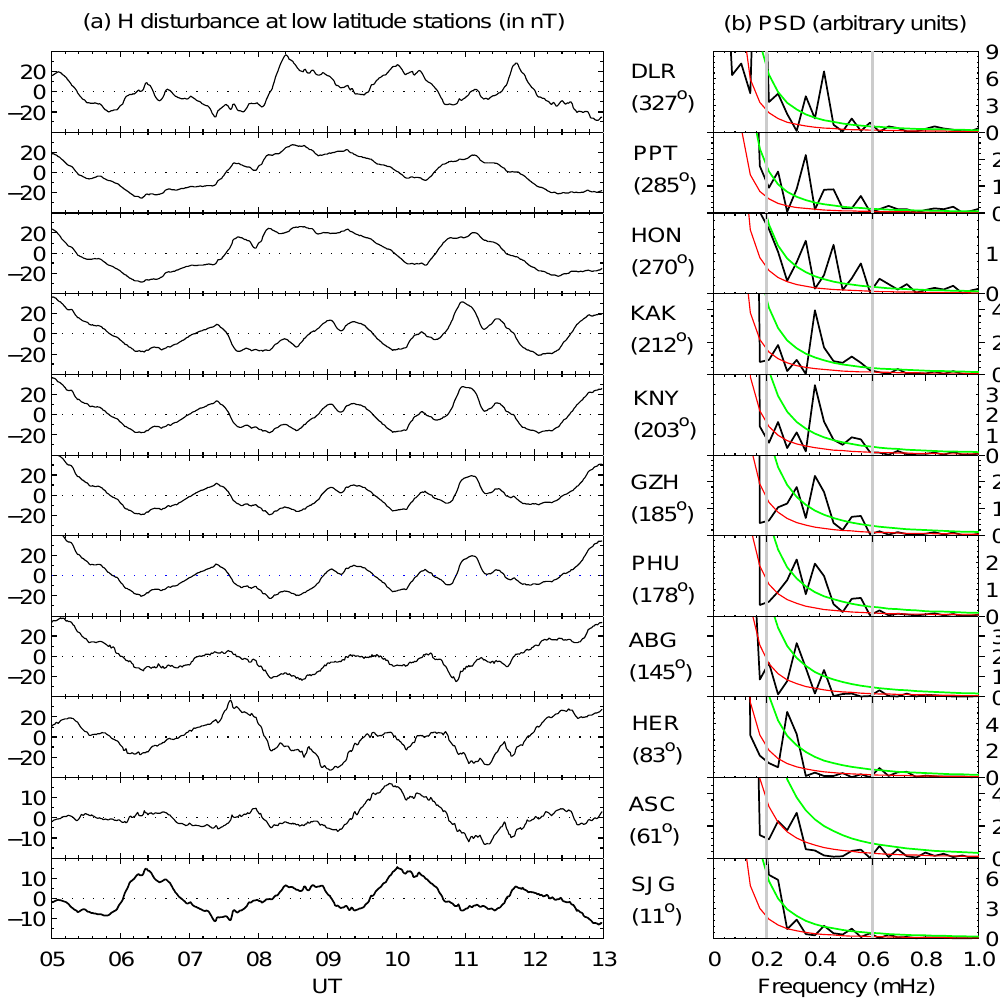
Fig. 2. 1H disturbance and FFT power spectra during 05:00–13:00UT on 15 October 2003. (a) 1H disturbance after removing the linear trend at longitudinally distributed 11 low latitude stations. Codes of stations and magnetic longitudes are given on the right side of the subplots. (b) Normalized power spectral density of 1H , mean red noise power (red curve) and 95% confidence level (green curve) at corresponding stations show globally high power in frequency band 0.2–0.6mHz (marked between pair of grey vertical lines).